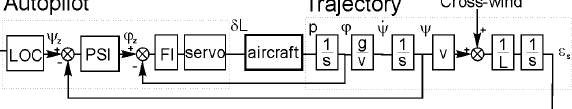
Fig 1. The ε s angle definition